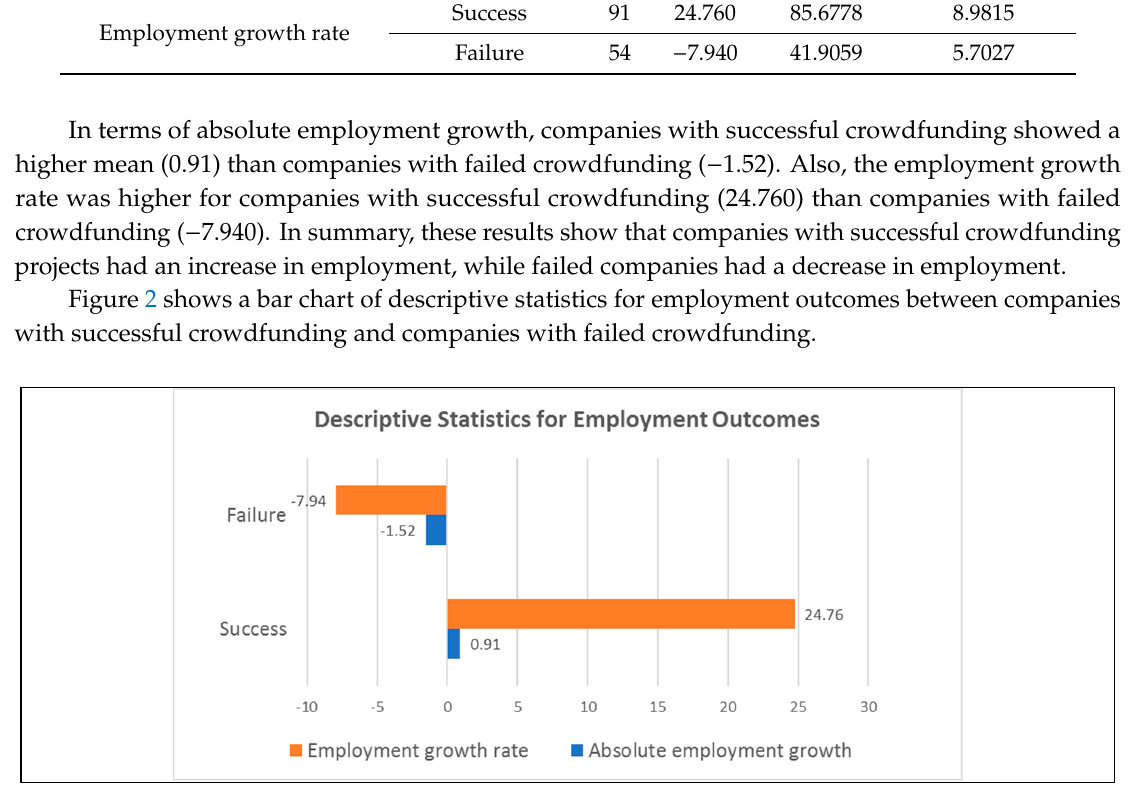
Table 7. Descriptive statistics for employment outcomes.